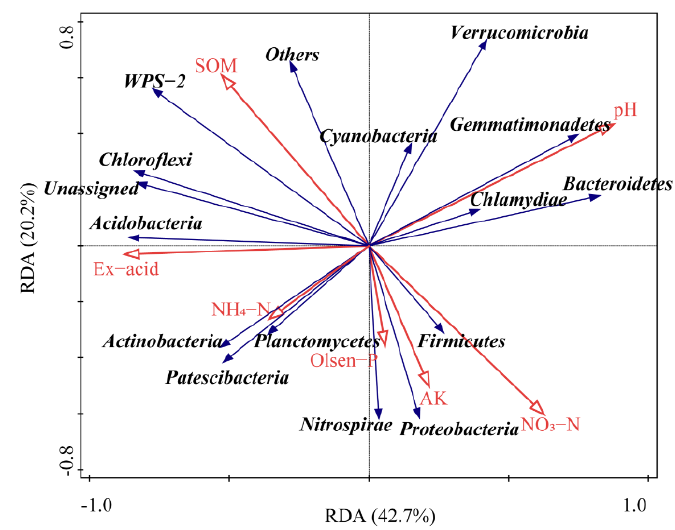
Figure 7. Redundancy analysis (RDA) of the relationship between soil chemical properties and relative abundance of bacterial phylum.